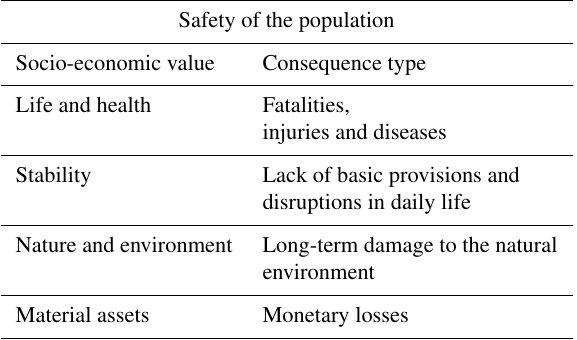
Table 1. Safety of the population specified through socio-economic values and corresponding consequence types (DSB,